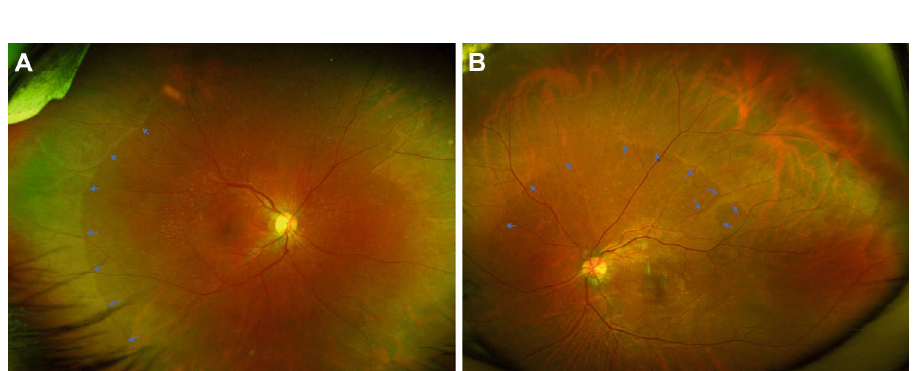
Figure 4. Representative images of risk factors detected by spectral domain optical coherence tomography (SD-OCT). ( A ) Stage 1 ERM; a continuous hyperreflectivity on the inner retinal surface on at least three consecutive scans of the macular volume. ( B ) Stage 2 ERM; stage 1 ERM with the presence of retinal folds but without associated foveal alteration. ( C ) Stage 3 ERM; stage 2 ERM with foveal involvement. ( D ) Vitreomacular adhesion. ( E ) Vitreomacular traction. ( F ) Vitreoschisis; a split in the posterior vitreous cortex (arrowheads). ( G ) Hyperreflective foci; discrete lesions protruding from the inner retinal surface. ( H ) Epiretinal mass; a homogenous collection of material with medium reflectivity at the inner retinal surface with a thickness greater than 20 µm.